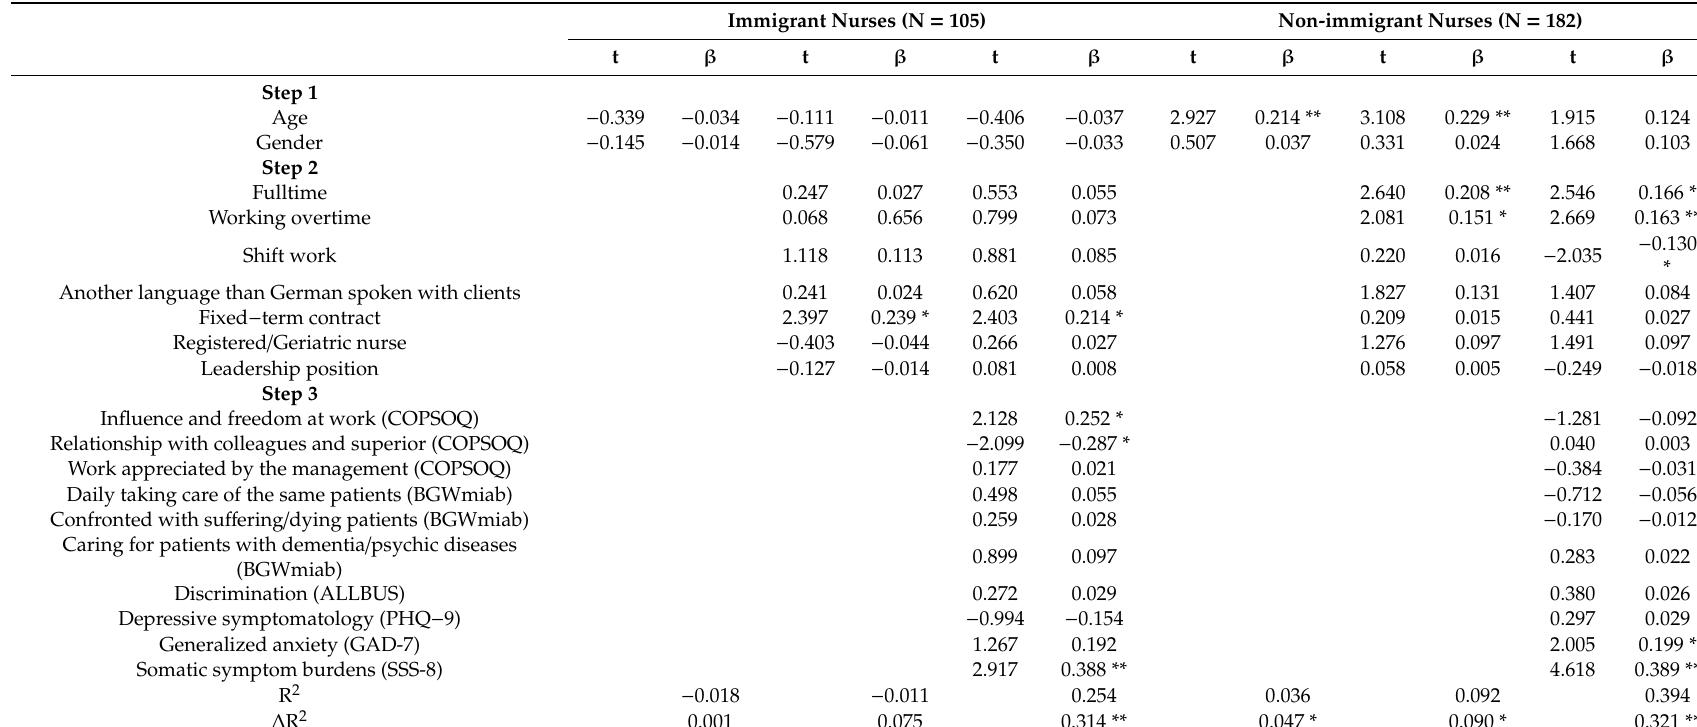
Table 4. Predictors for psychosocial